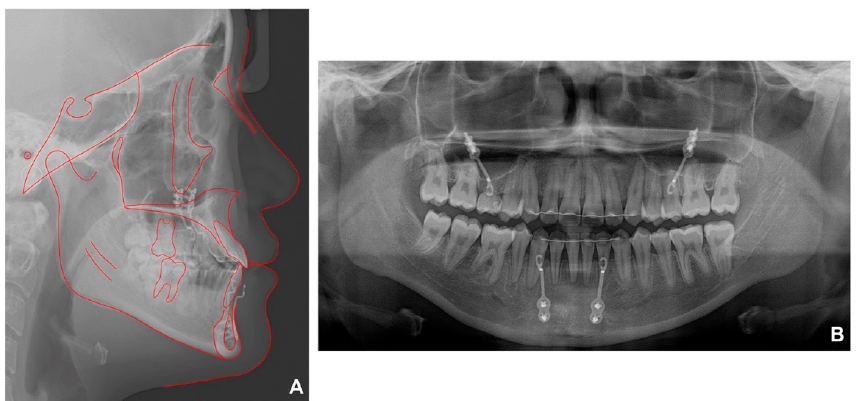
Figure 7. Radiographs after debonding: ( A ) lateral cephalometric radiographs; ( B ) panoramic radi- ograph.